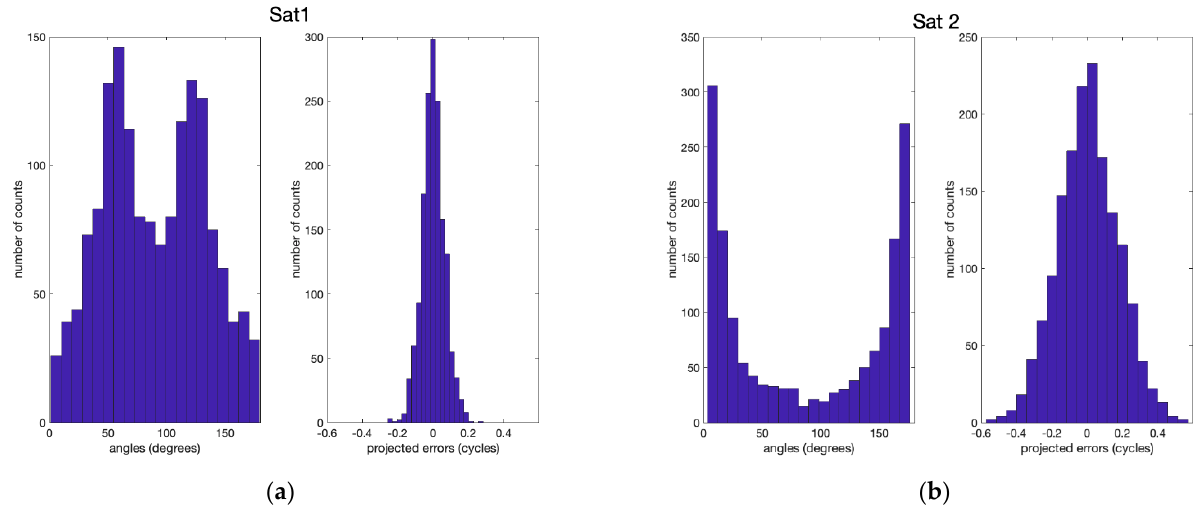
Figure 3. Statistics of the relative angles between the double difference line-of-sight vectors and b 0 are shown in the left column in ( a ) and ( b ) for satellite 1 and satellite 2, respectively. Their inner product values are shown in the right columns.